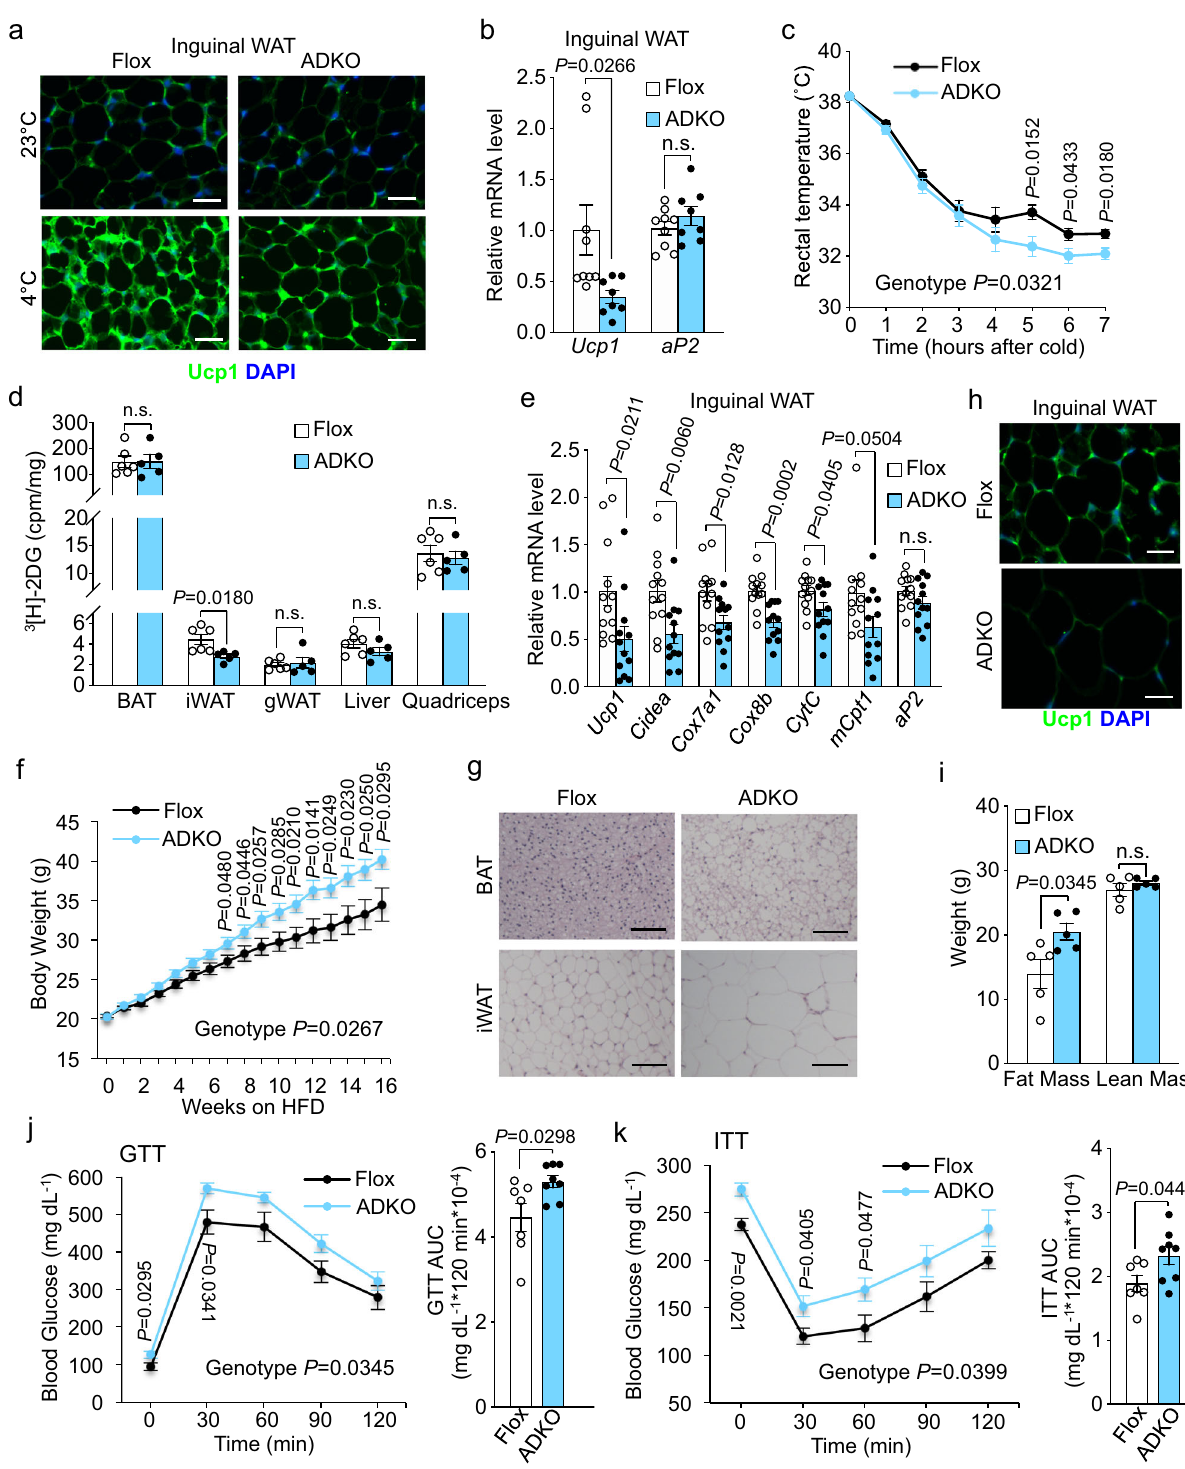
Fig. 3 | Adissp is required for iWAT browning and energy homeostasis. a Representative images of Ucp1 immuno fl uorescence staining in iWAT from 3- month-old male Adissp adipose-speci fi c knockout (ADKO) mice and Flox controls housed at room temperature and after 8h cold exposure ( n =3 mice per group). Scale bar, 200 μ m. b Gene expression analysis in iWAT from 5-month-old female Adissp ADKO mice(n=8)and Floxcontrols ( n =9) after 7hcoldexposure. c Rectal temperature of mice from ( b ) during cold exposure. d Quanti fi cation of 3 H-2DG uptakeinindicatedtissuesfromfemale Adissp ADKOmice( n =5)andFloxcontrols (n=6) after 3h coldexposure. e Gene expression analysis in iWATfrom 2 days CL- 316,243(1mg/kgbodyweight)administrated3-month-oldfemalemice(n=12mice